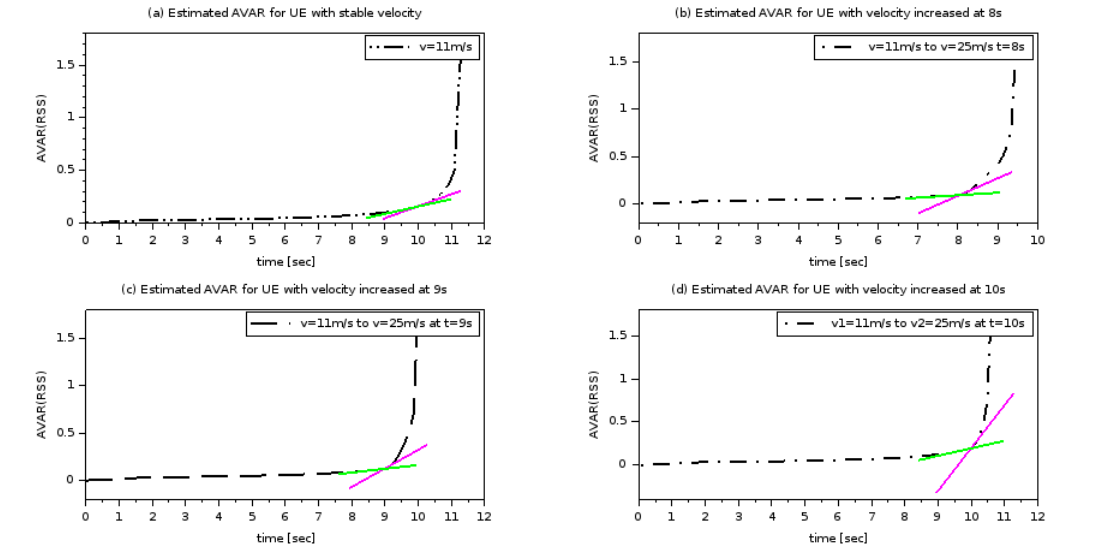
Figure 3. The AVAR of the RSS for the UE entering the AP